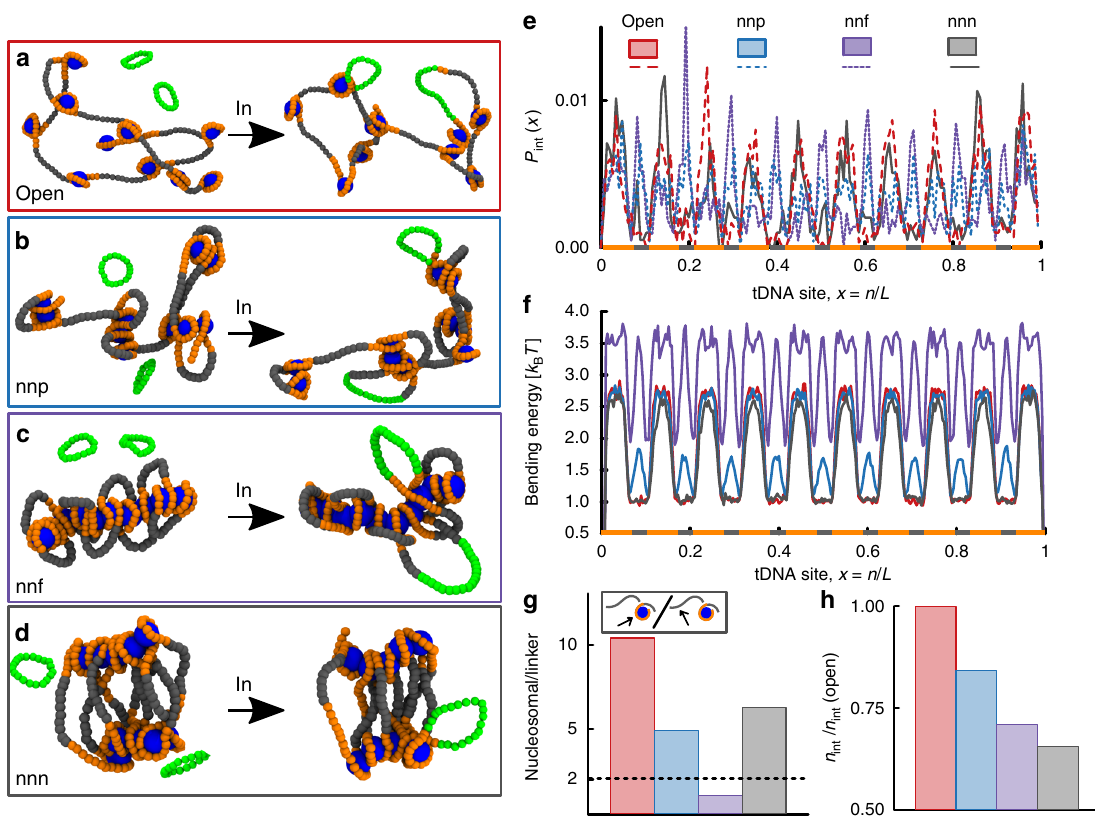
Fig. 2 Local chromatin structure affects nucleosomal integration. a Snapshot of an open chromatin fi bre composed of 10 nucleosomes. Nearest-neighbour (nn) attraction between the histone-like particles induce partially folded (nnp, ( b )) and fully condensed (nnf, ( c )) structures. Next-nearest-neighbour attractions lead to zig – zagging fi bres (nnn, ( d )). e The integration probability P int ( x ) as a function of the relative tDNA site x = n / L displays peaks whose location depend on the compaction level. Open fi bres are integrated mostly within nucleosomes while folded arrays also display peaks within linker DNA. f The bending energy pro fi le shows that fi bres with nearest-neighbour attractions (nnp and nnf) but not those with next-nearest-neighbour attraction, display stress within linker DNA. This only partially explains why these regions are targeted within these chromatin structures. g The ratio of nucleosomal versus linker DNA integrations suggest that not only energy barrier but also dynamic accessibility plays a role in determining the integration pro fi les (the expected value for random integration 200/90 = 2.2 is shown as a dashed line). h The number of successful integration events over the total simulation time, n int , decreases with chromatin condensation. In all cases, the fi bre is reconstituted independently before performing the quasi-equilibrium stochastic integration. Data are generated by averaging over 2000 independent integration events. See Supplementary Movies 3 – 6 for the full dynamics. Source data are provided as a Source Data fi